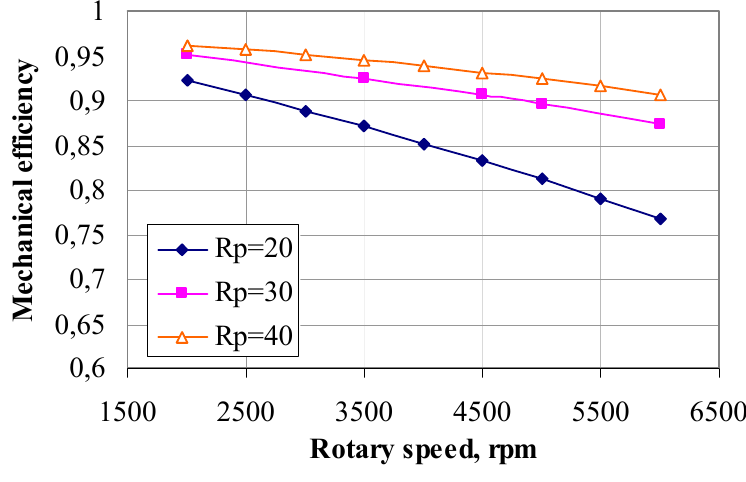
Figure 7. Evolution of the mechanical efficiency at different pressure ratios and rotary